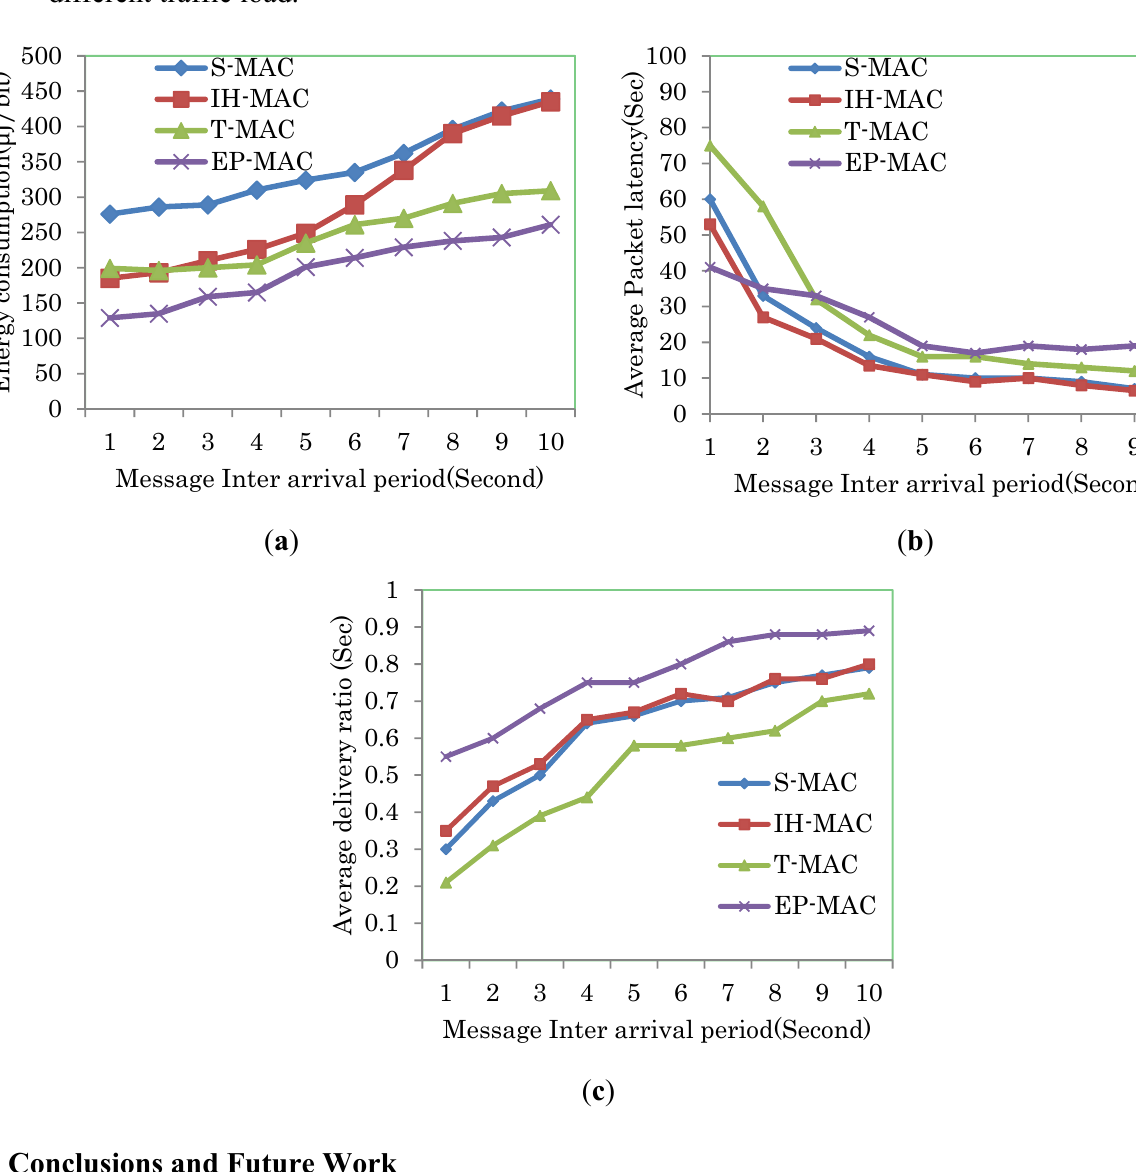
Figure 6. ( a ) Average energy consumption per bit under different traffic load; ( b ) Average Packet Latency under different traffic load; ( c ) Average Packet delivery ratio under different traffic